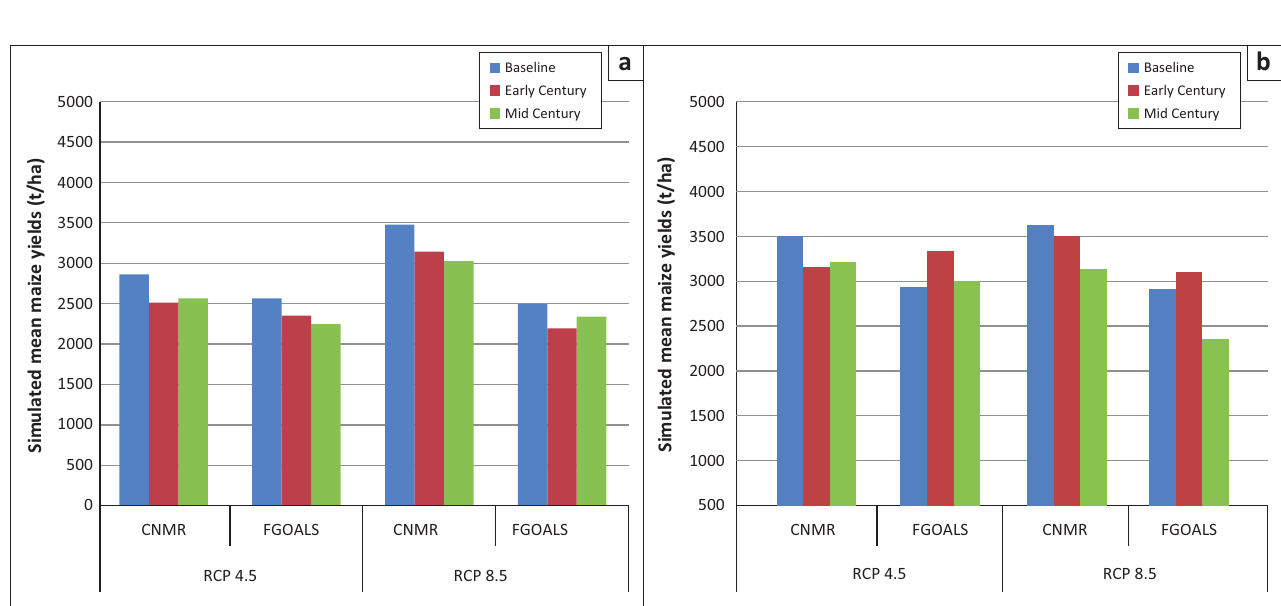
FIGURE 6: Simulated mean yields per location (a) Alice and (b) Lambani.